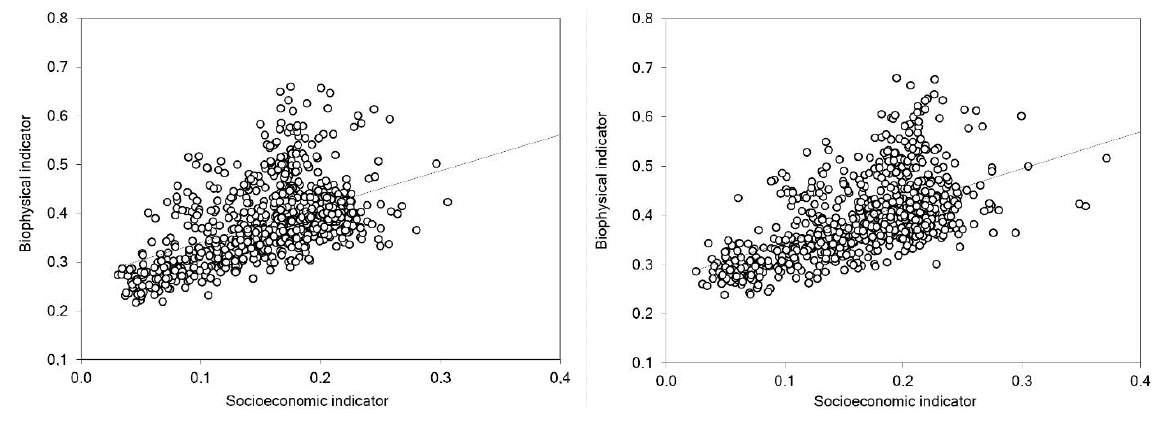
Figure 3. The relationship between socioeconomic and biophysical indicators of soil sensitivity to degradation in Italy at the spatial level of agricultural homogeneous districts ( left : Early-1990s and right : Early-2010s).